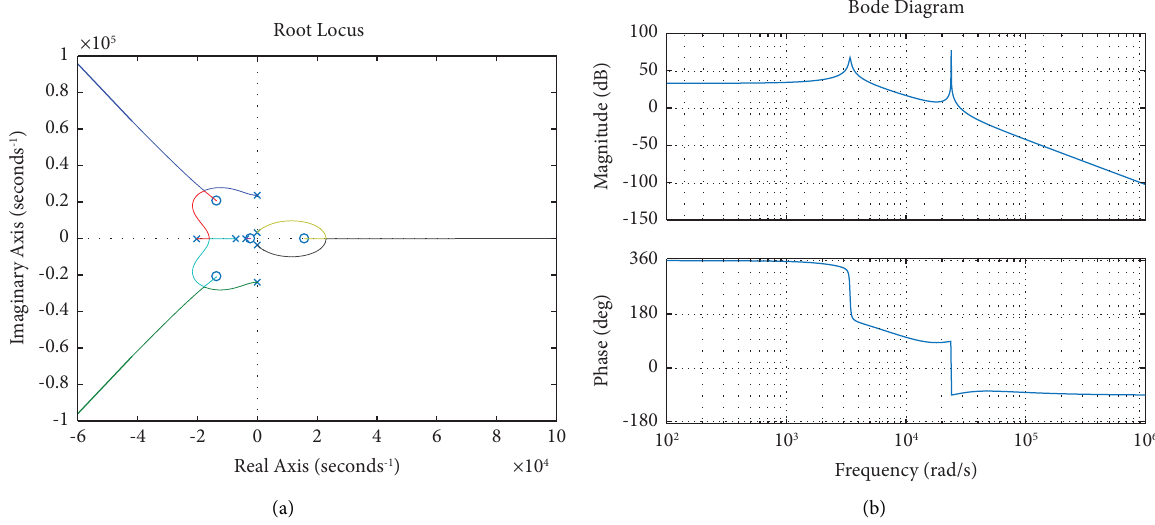
Figure 14: Cuk converter plus LC series damping flter: (a) root locus; (b) bode.